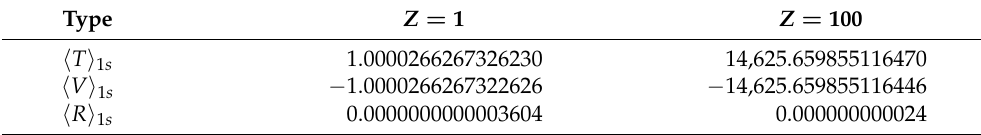
Table 3. Comparison of kinetic (cid:104) T (cid:105) 1 s and potential (cid:104) V (cid:105) 1 s energies for a 1 s electron for Z = 1 and Z = 100 hydrogen-like atoms. For an exact solution, (cid:104) T (cid:105) 1 s + (cid:104) V (cid:105) 1 s = 0 but